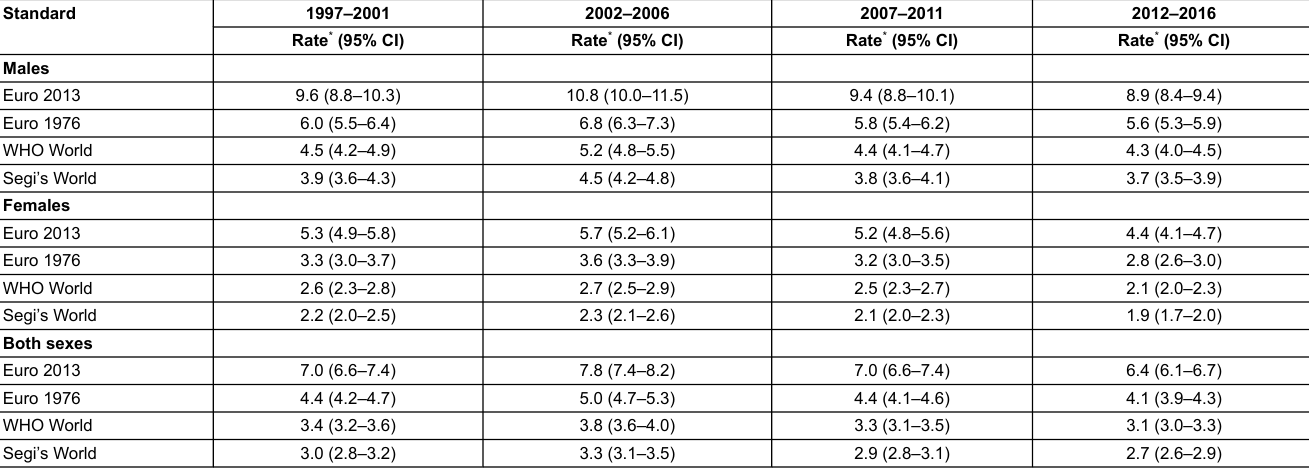
Table S3: Age-adjusted incidence of chronic lymphocytic leukaemia / small lymphocytic lymphoma in Switzerland, 1997–2016.